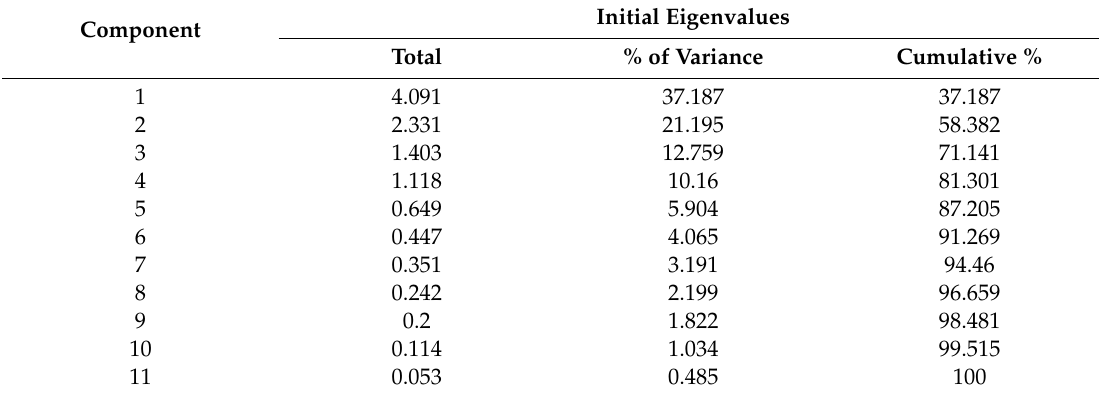
Table 4. Eigenvalues and variances (components with an eigenvalue greater than one are bold).